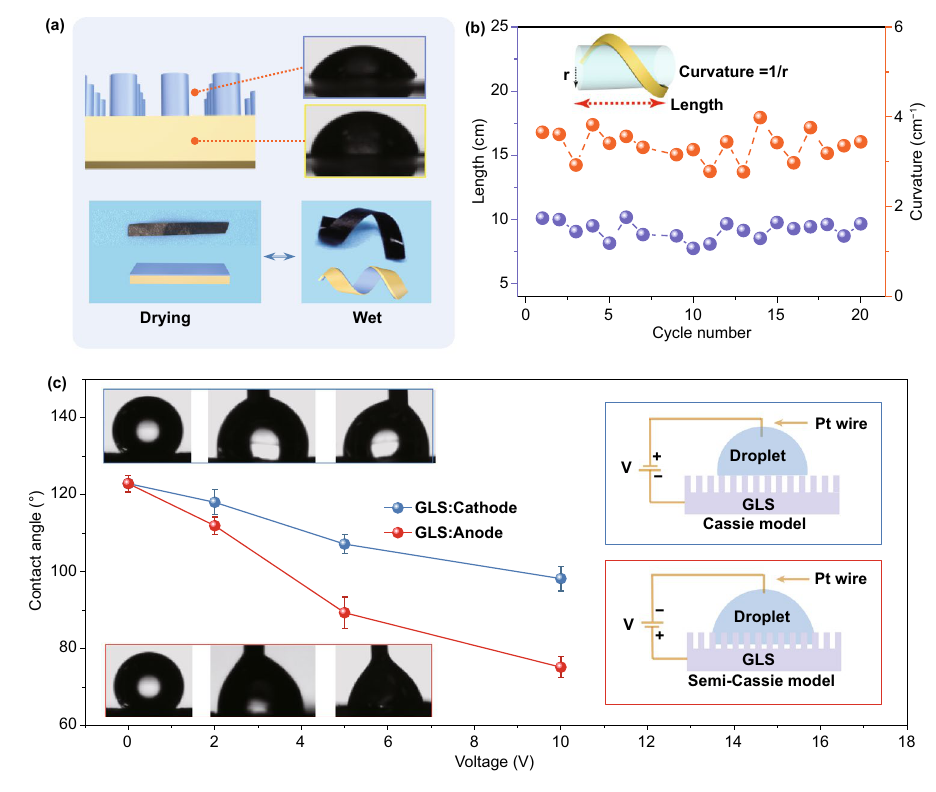
Fig. 7 a Schematic illustrations of Janus imprinted Pi-rGOS with different static contact angle on each side (top) and the reversible morphing behavior of Pi-rGOS (bottom). b Plots of length and curvature of Janus film versus cycle number during multiple wetting tests. c The change of apparent contact angle with a function of voltage when the GLS was settled as cathode (blue) and anode (red), respectively, and their corre- sponding Cassie and Semi-Cassie contact